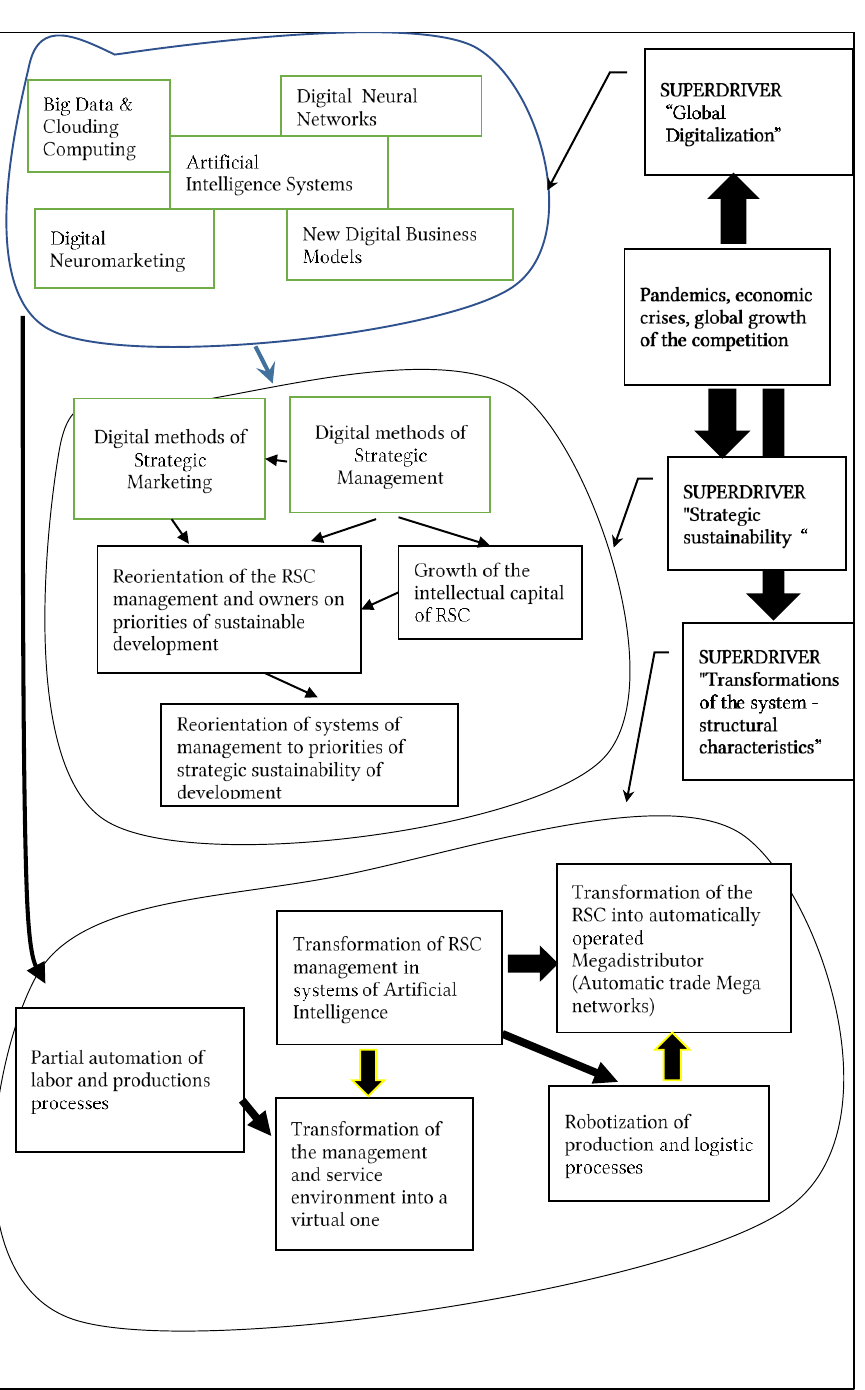
Figure 1. System model of digital technologies impact on RCS transformation under superdriver’s actions.